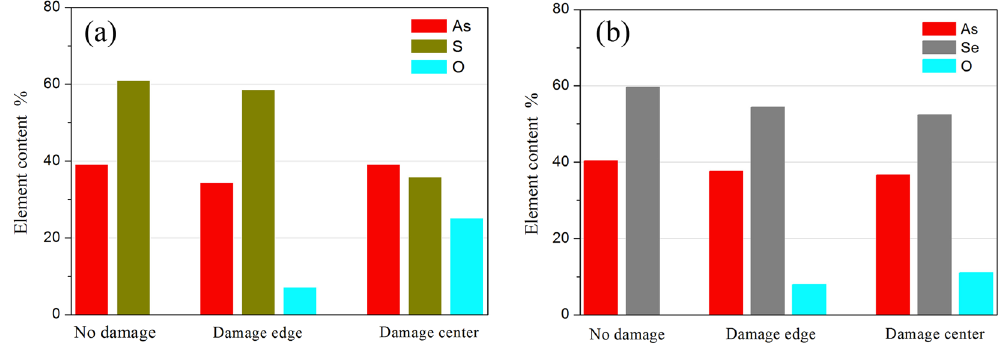
Figure 8. ( a ) Elemental compositions of As 2 S 3 ; ( b ) Elemental compositions of As 2 Se 3 . The samples were damaged at 3 μ m as an